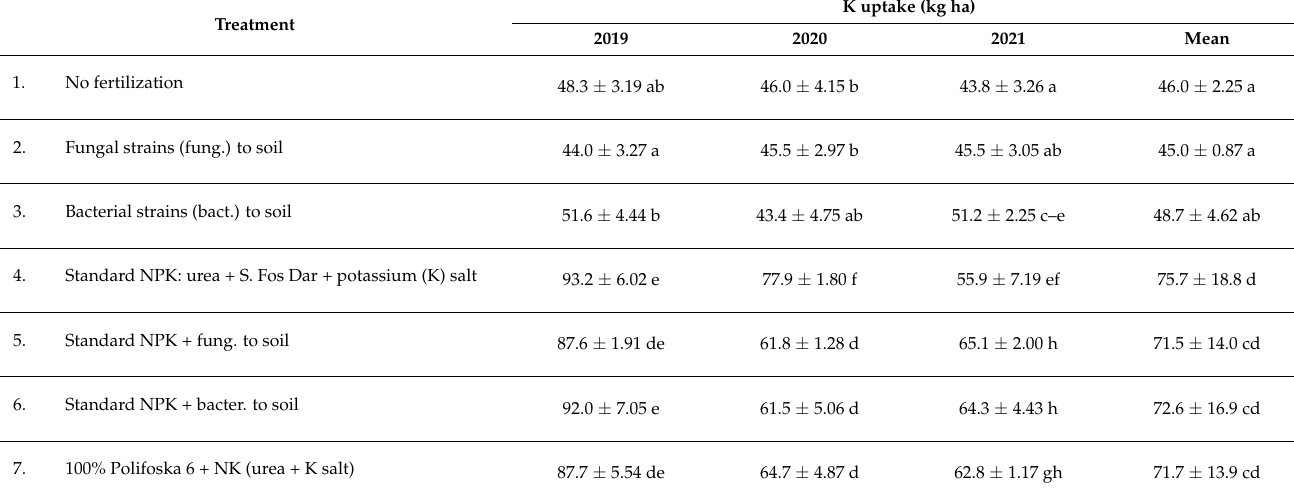
Table 8. K uptake by weed shoots in the apple orchard, 2019–2021.